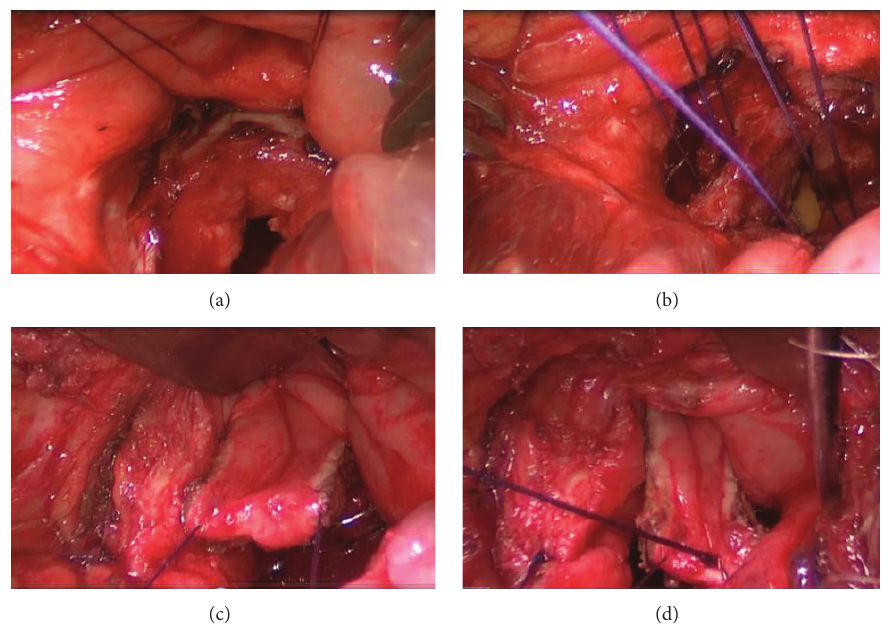
Figure 5: Pictures showing the dissection and closure of RUF. (a) All through the anterior rectal wall and posterior urethral wall were separated by sharp dissection. (b) After separation, first closure of the urethral wall by interrupted suture is seen. (c) After finishing posterior urethral wall closure, prepared rectal advancement flap from proximal side is seen. (d) After preparing rectal advancement flap, its fixation with interrupted sutures one by one is seen.